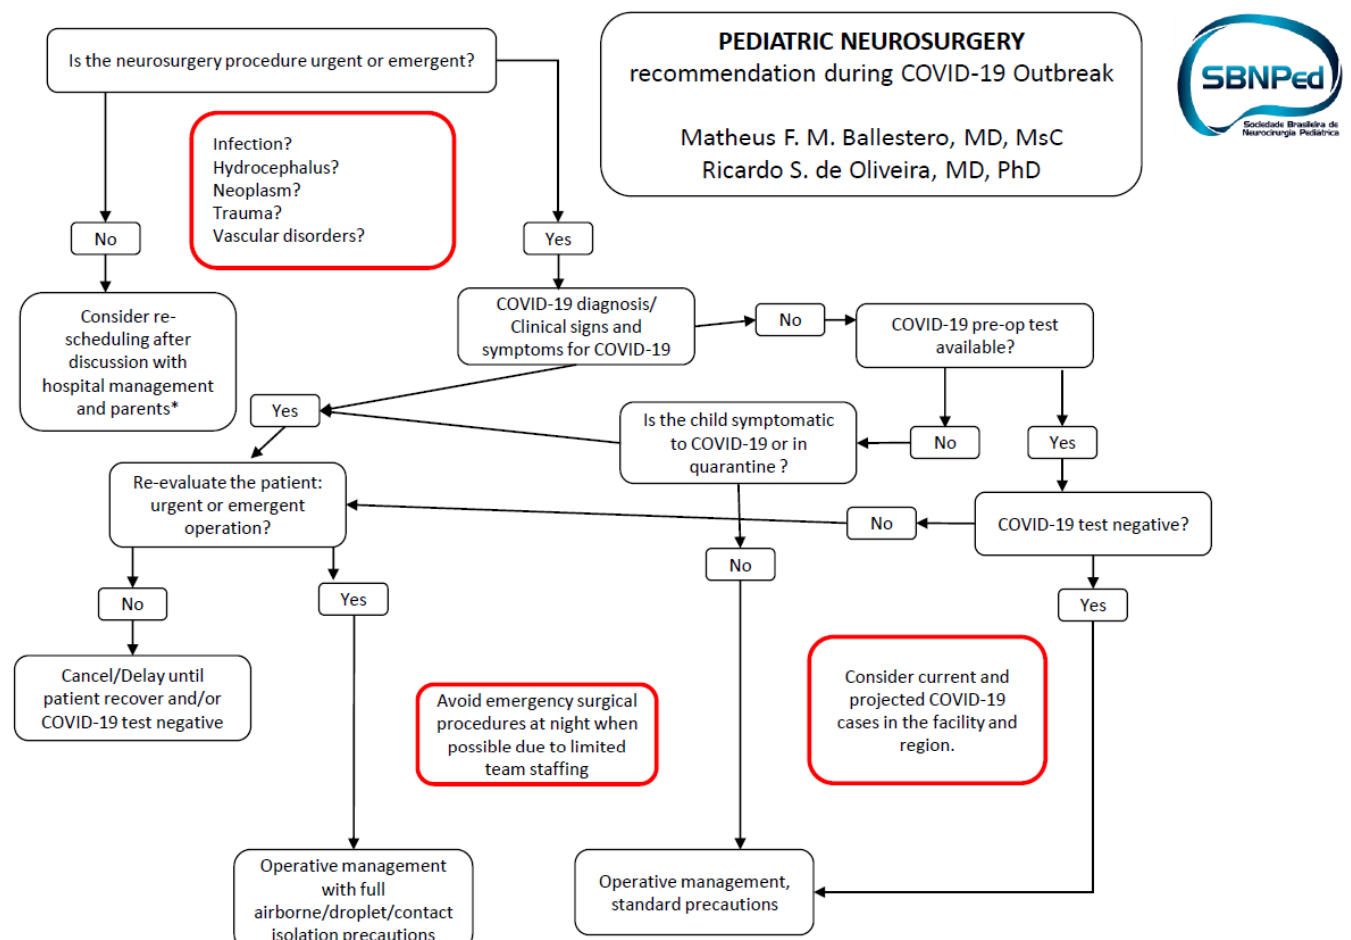
Figure 1 – Brazilian Society of Pediatric Neurosurgery recommendation during COVID-19